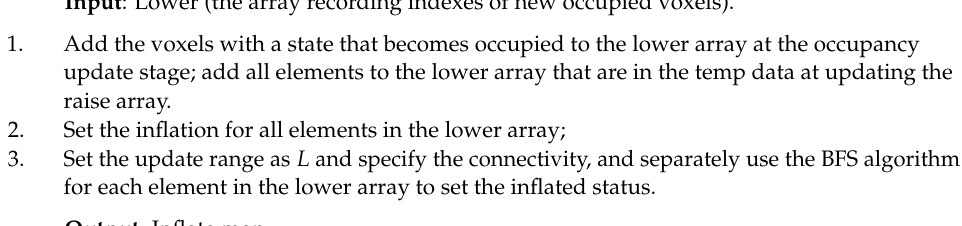
Algorithm 2 Inflate the map for lower